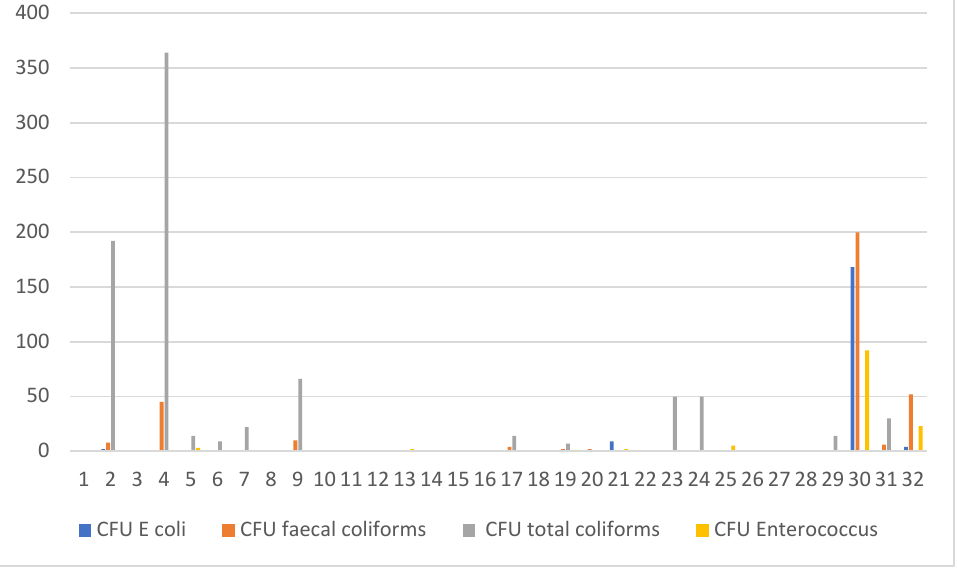
Figure 2. A graphical illustration, in cfu/mL, of E.coli, Enterococcus, total coliforms and fecal coliforms per farm.